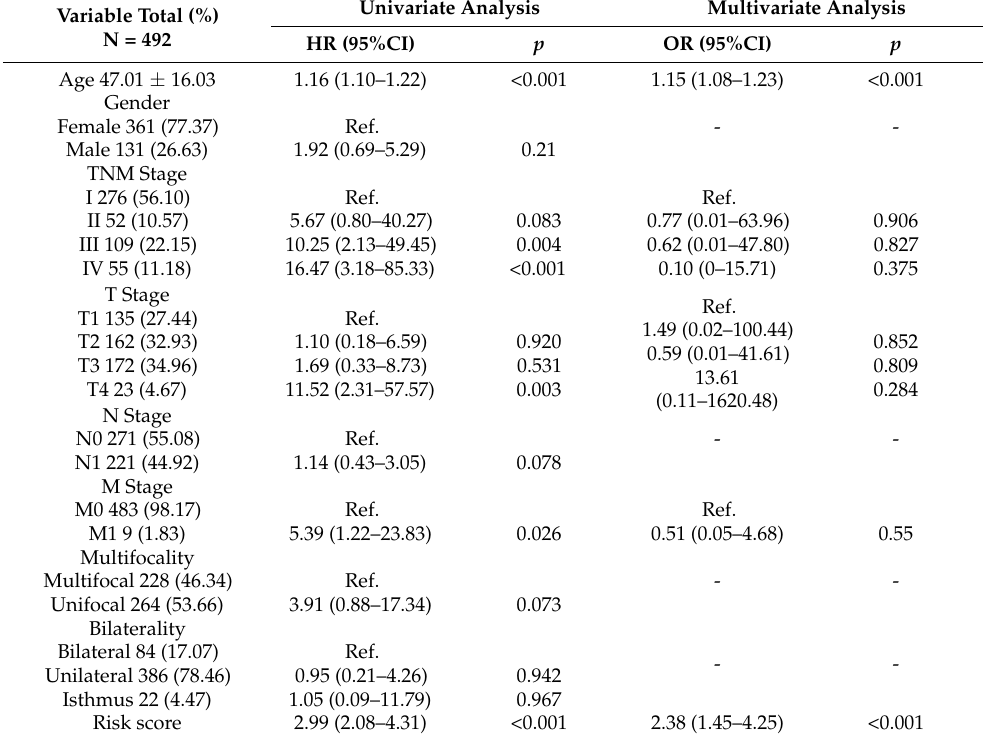
Table 1. Univariate and multivariate Cox regression analysis the prognosis factors of PTC.